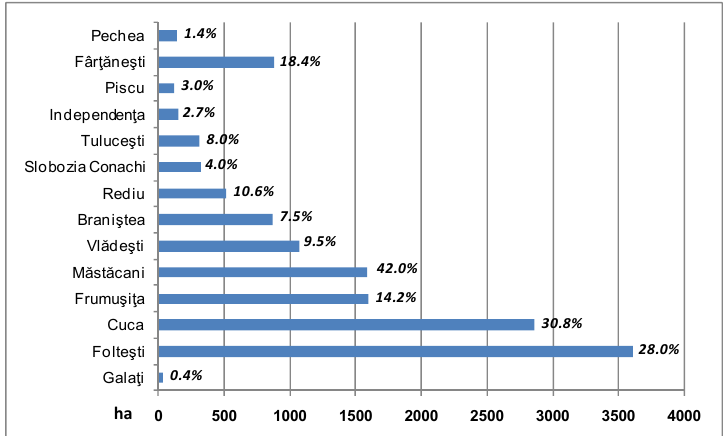
Figure 5. Forest-covered areas at the level of administrative units in 1892, processed after Pacu (1892) [65].